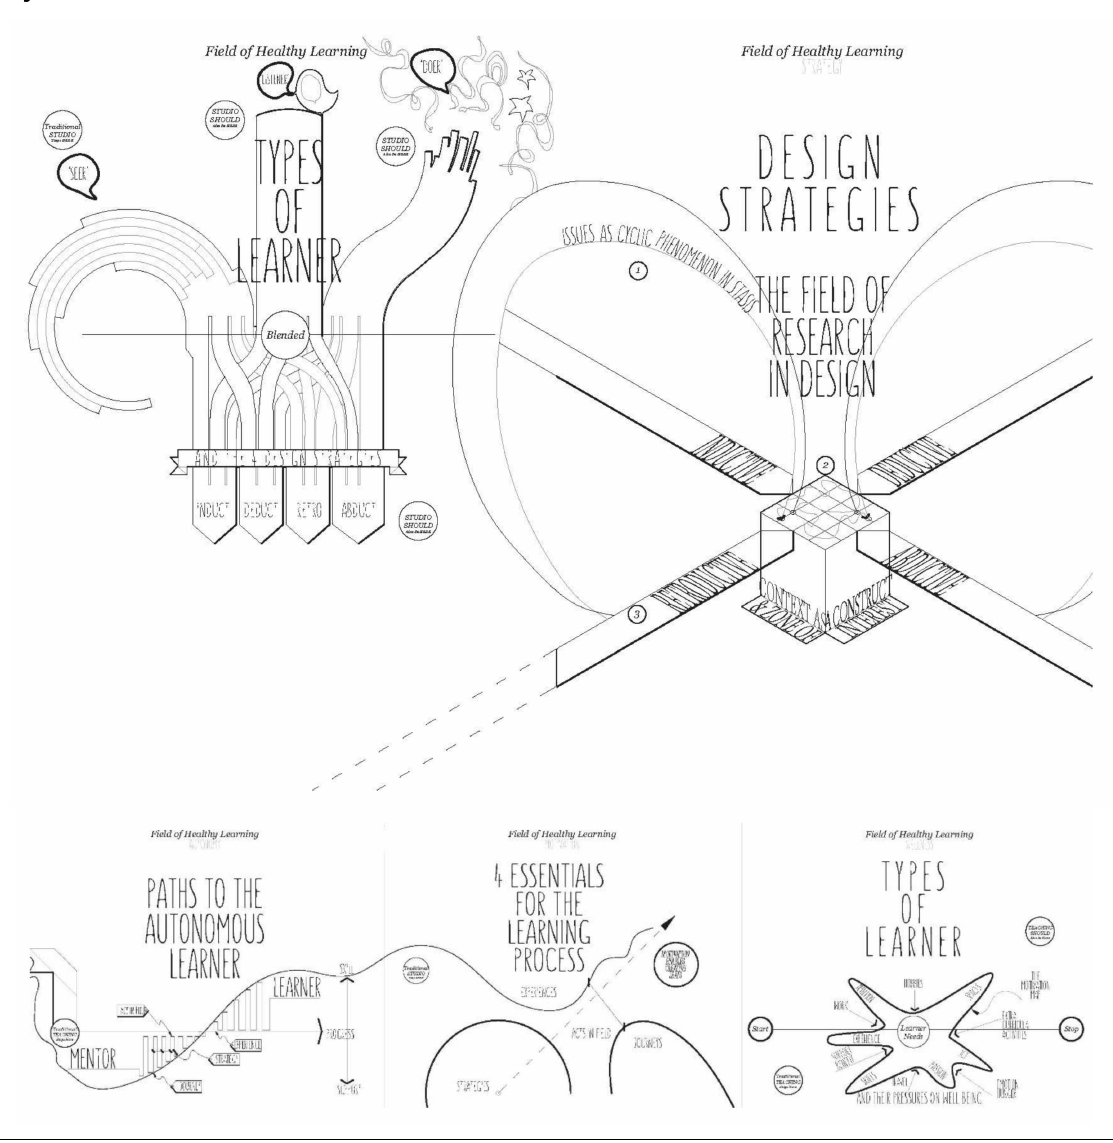
Figure 4. Field of healthy learning approaches in curriculum design strategies (Source: